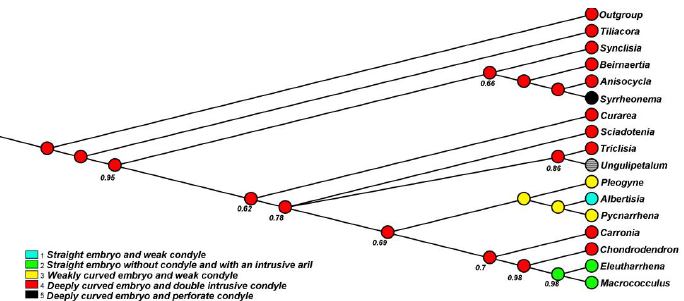
Figure A1 . Heuristic search and majority rule consensus of Tiliacoreae based on 17 morphological characters using Mesquite. Endocarp ancestral character states mapped and visualized using the ball and stick method. Consensus tree supports 1 except when stated.